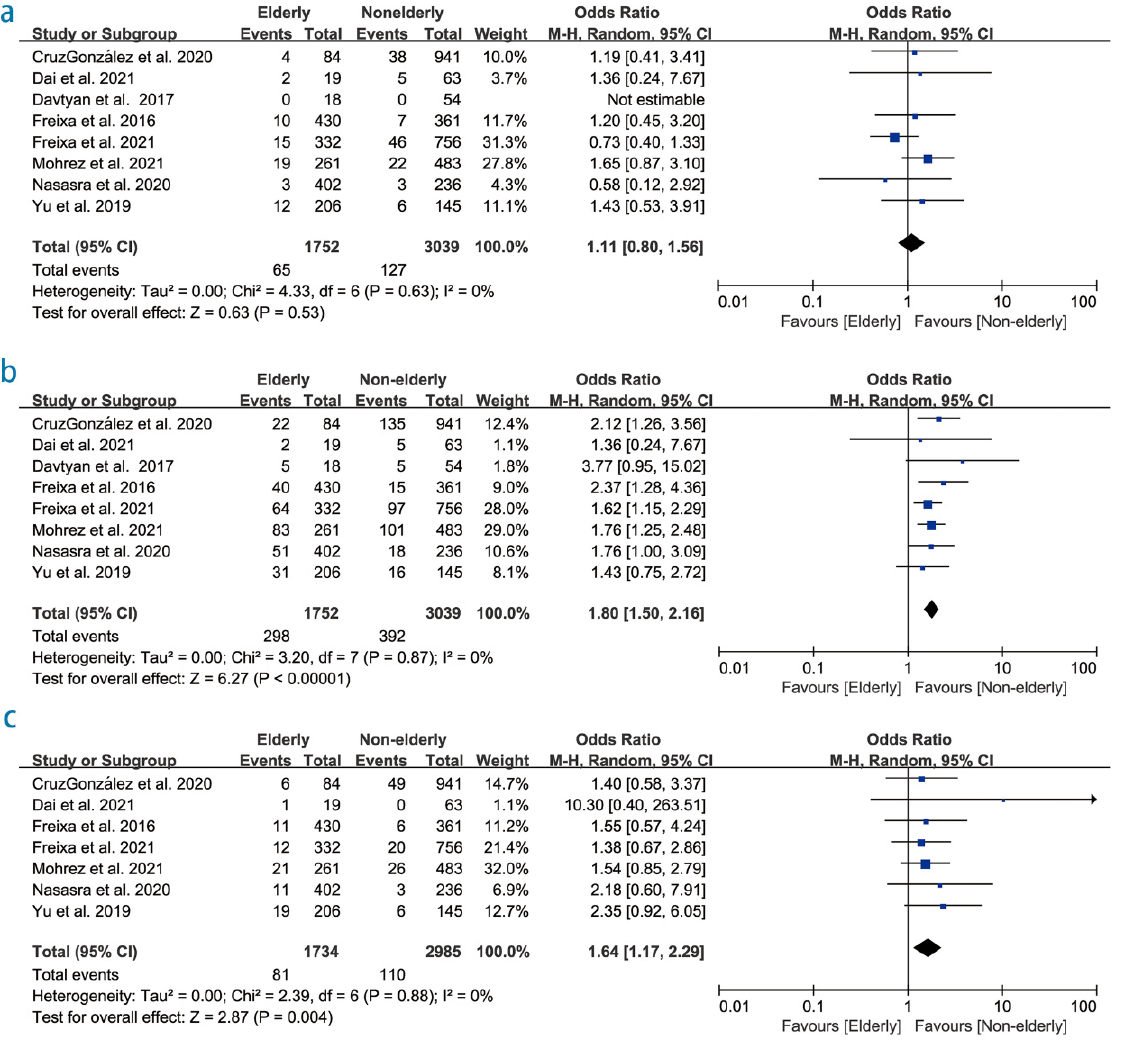
Figure 4. Forest plot showing the effect of left atrial appendage closure on ( a ) the risk of stroke/transient ischemic attack, ( b ) all-cause death, and ( c ) major bleeding events in the follow up time [14,17,20,22,23,25,26].